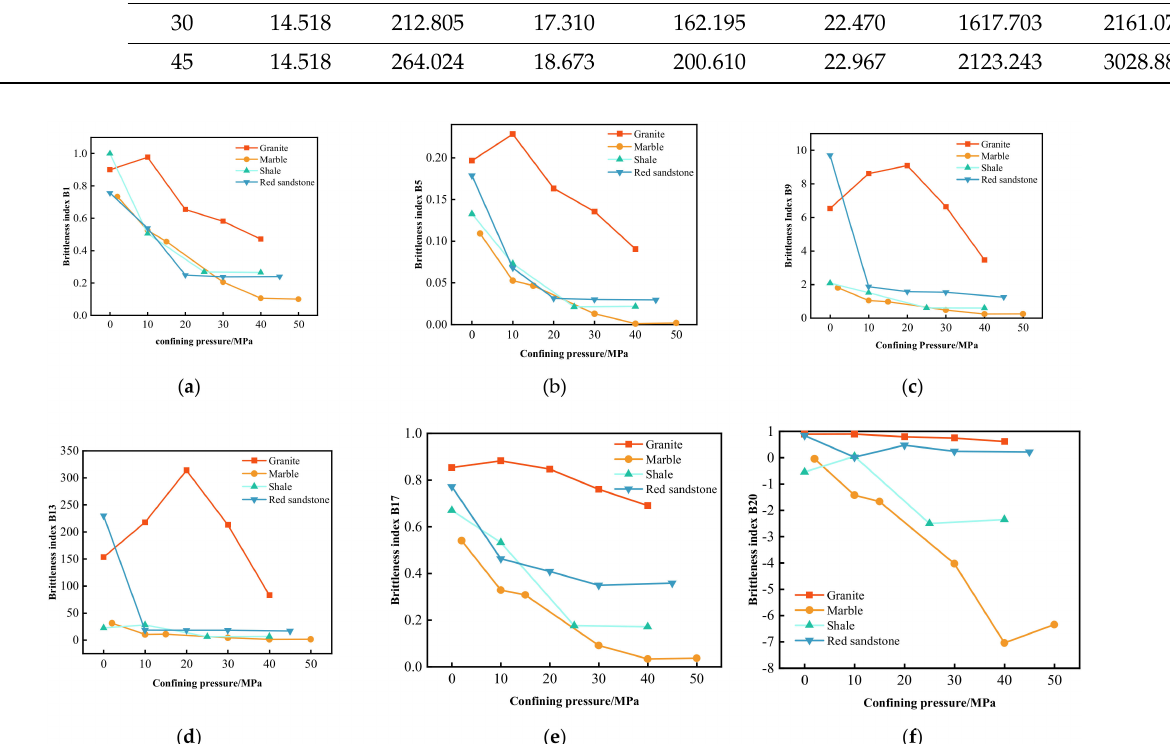
Figure 4. Brittleness index of various types of rocks under different confining pressures. Note: ( a – f ) represent the characterization results of different rock samples by brittleness indexes of B 1 , B 5 , B 9 , B 13 , B 17 , and B 20 ,